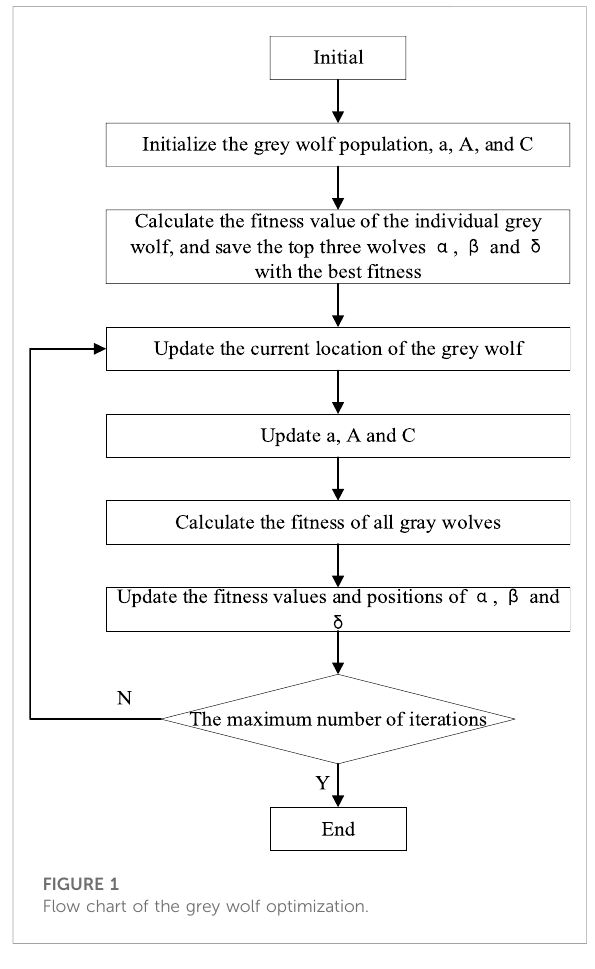
FIGURE 1 Flow chart of the grey wolf